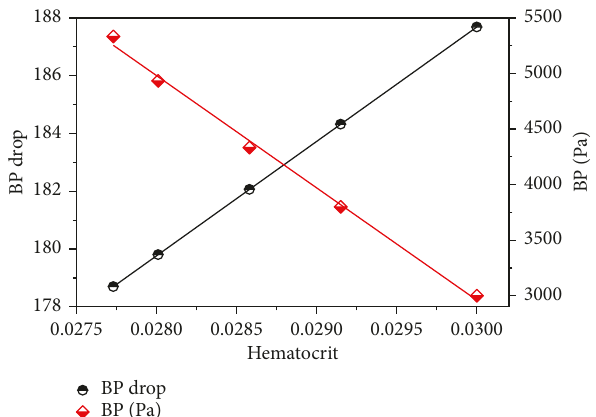
Figure 1: Mathematical data of BP drop (calculated using (66)) and BP (in Pa) as a function of hematocrit, by Table 1 . Table 3: Clinical data and calculated BP values of jaundice patient (name: A , age: 43, and sex: F). Date